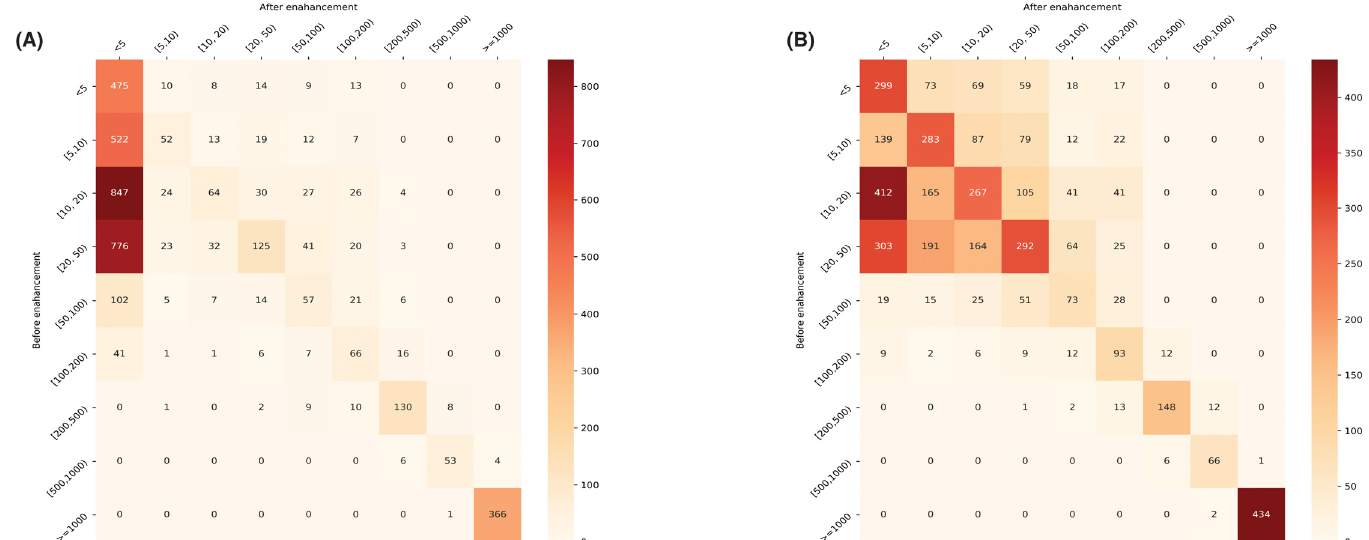
Fig 3. Change matrices for evaluating the enhancement effect of the UNet and CNN model. (A) Change matrix of the enhancement using the UNet model. (B) Change matrix of the enhancement using the CNN model.